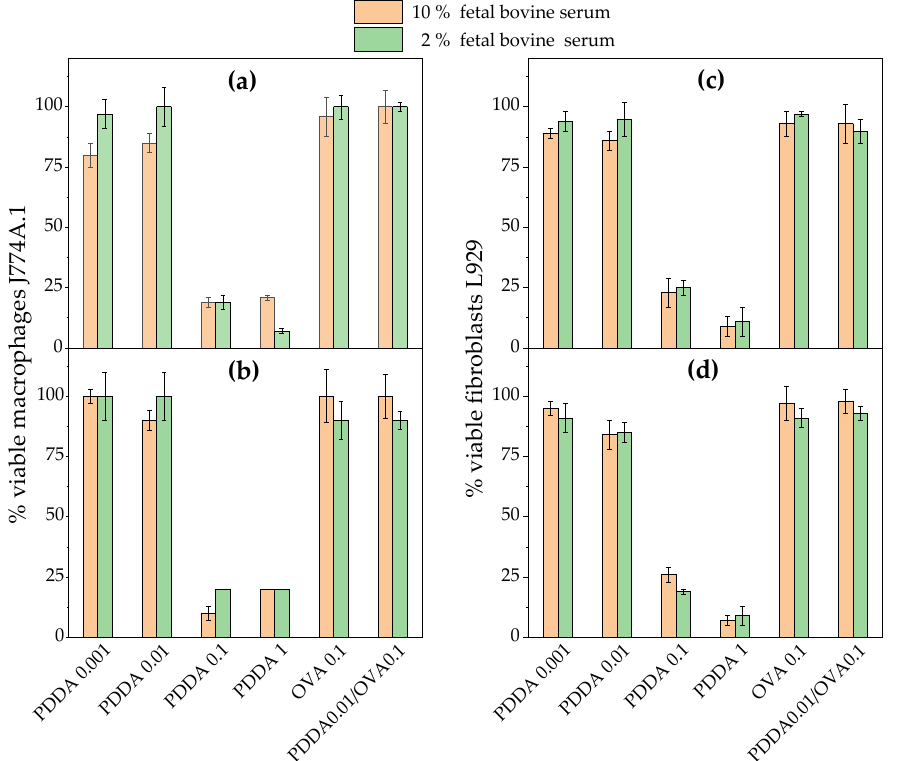
Figure 5. Cell viability (%) of macrophages (J774A.1) or fibroblasts (L929) in culture from the 3-(4,5-dimethylthiazol-2-yl)-2,5-diphenyl tetrazolium bromide (MTT) assay after incubation for 3 ( a , c ) or 24 h ( b , d ) with PDDA, OVA, and PDDA/OVA NPs. Concentrations are given in mg·mL −1 . One should notice that the formulation used for the immunology experiments were 0.01 and 0.1 mg. mL −1 of PDDA and OVA, respectively.